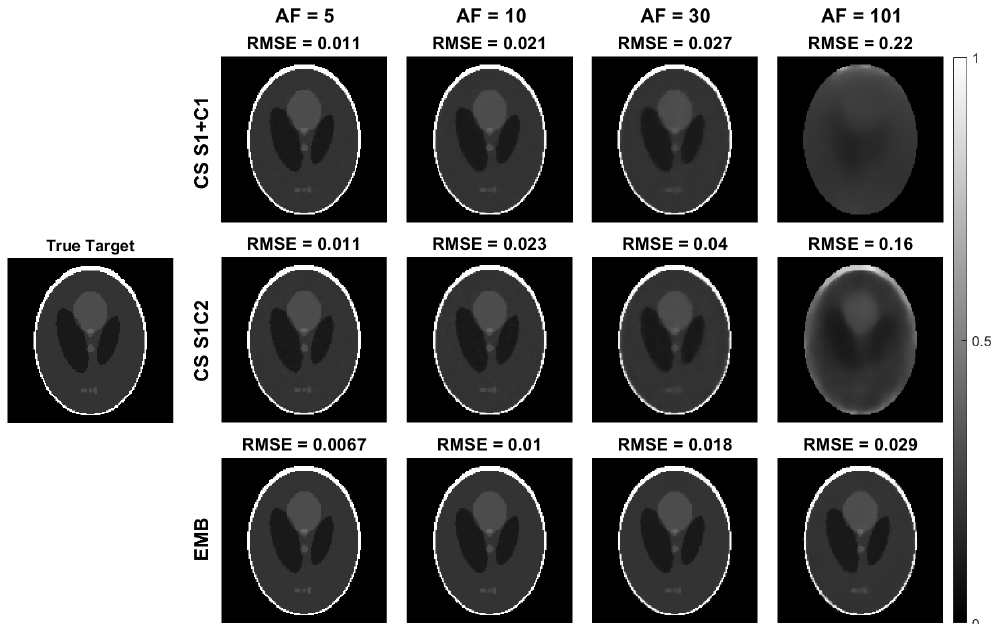
Figure 5. The S 0 maps of the radial simulation reconstructed with the embedded model and the two CS models, and the RMSEs of the reconstructions as compared to the true values used in the simulation. The S 0 maps shown here are from the same reconstructions as the T 1 ρ maps shown in Figure 4. The top row contains the CS S1+C1 model, and the middle row the CS S1C2 model S 0 parameter maps obtained from the monoexponential fit of Equation (15), and the bottom row contains the embedded model reconstructions. Columns 2–5 show the S 0 parameter maps at acceleration factors 5, 10, 30, and 101. Images are cropped to content.